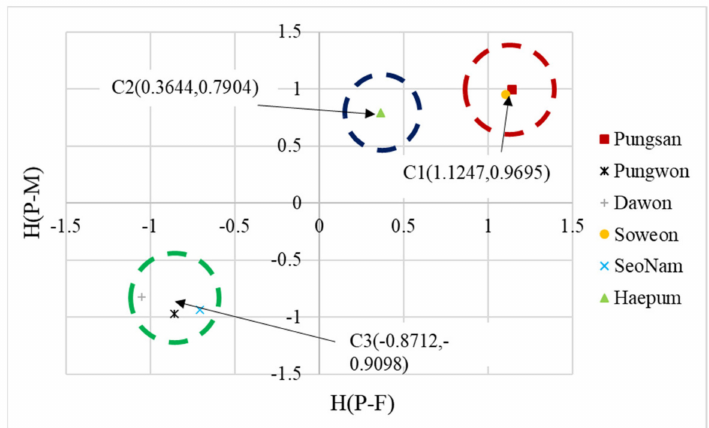
Figure 4. Visualization of k-mean clustering based on normalization scores (C1: Cultivar Group 1, C2: Cultivar Group 2, and C3: Cultivar Group